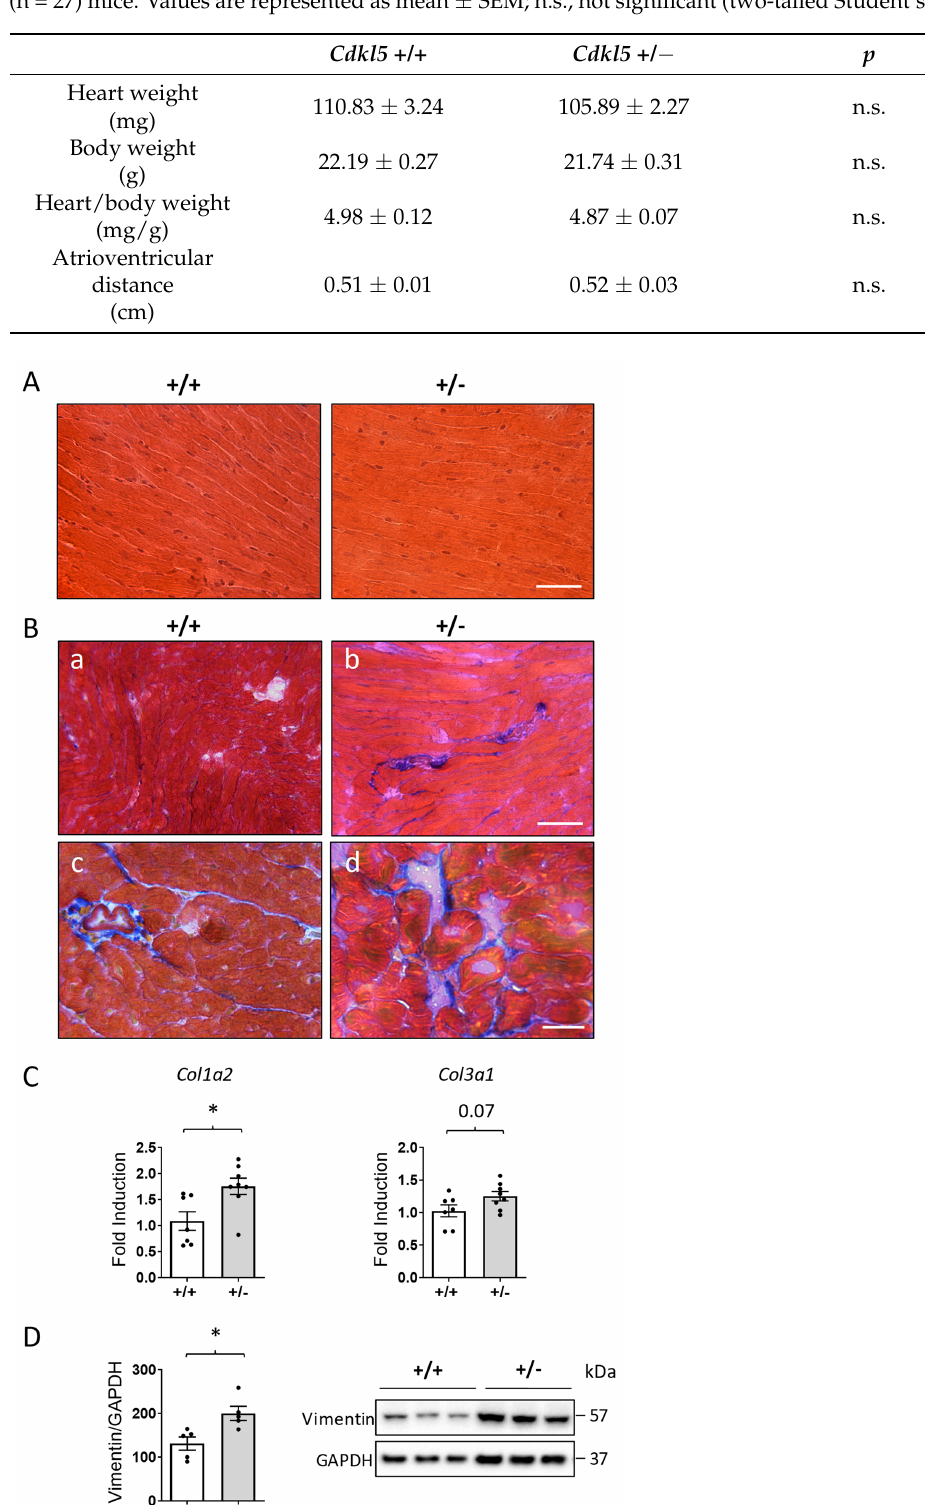
Table 3. Effect of genotype on heart weight and dimension. Heart weight, body weight, heart over body weight ratio, and atrioventricular distance of 3–4-month-old Cdkl5 +/+ (n = 18) and Cdkl5 +/ − (n = 27) mice. Values are represented as mean ± SEM; n.s., not significant (two-tailed Student’s t -test).